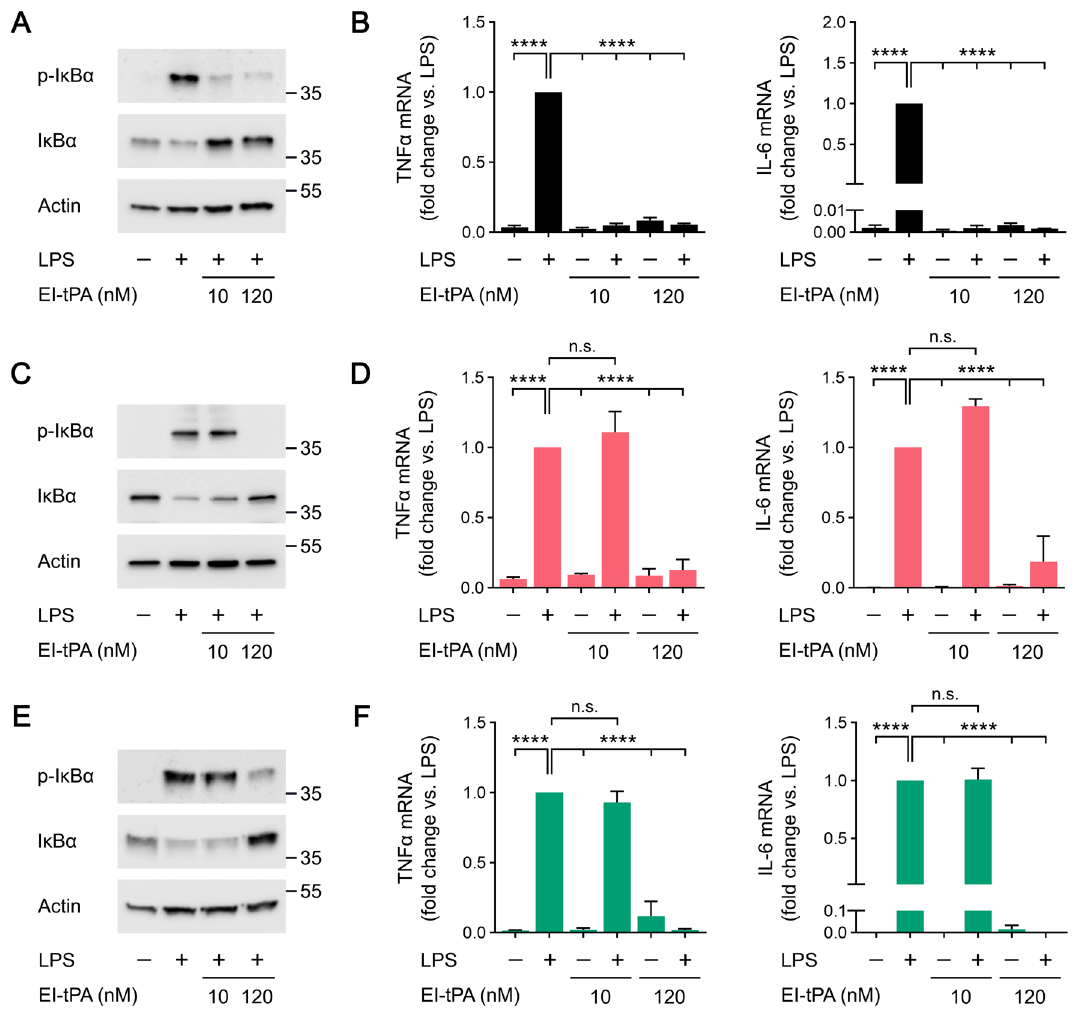
Figure 4. The anti-inflammatory activity of EI-tPA is facilitated by membrane-anchored PrP C and LRP1. ( A ) BMDMs isolated from WT mice were treated for 1 h with LPS (0.1 μg/mL), LPS plus 10 nM El-tPA, LPS plus 120 nM El-tPA, or vehicle. Cell extracts were subjected to immunoblot analysis to detect phospho-IκBα, total IκBα, and β-actin. (B) WT BMDMs were treated with LPS (0.1 μg/mL), LPS plus 10 nM El-tPA, LPS plus 120 nM El-tPA, or vehicle for 6 h. RT-qPCR was performed to compare mRNA levels for TNFα and IL-6 (n = 4–6). (C) PrP C -deficient BMDMs isolated from Prnp −/− mice were treated for 1 h with LPS (0.1 μg/mL), LPS plus 10 nM El-tPA, LPS plus 120 nM El-tPA, or vehicle. Cell extracts were subjected to immunoblot analysis to detect phospho-IκBα, total IκBα, and β-actin. (D) PrP C -deficient BMDMs were treated with LPS (0.1 μg/ mL), LPS plus 10 nM El-tPA, LPS plus 120 nM El-tPA, or vehicle for 6 h. RT-qPCR was performed to compare mRNA levels for TNFα and IL-6 (n = 4–5). (E) LRP1-deficient BMDMs isolated from mLrp1 −/− mice were treated for 1 h with LPS (0.1 μg/mL), LPS plus 10 nM El-tPA, LPS plus 120 nM El-tPA, or vehicle. Cell extracts were subjected to immunoblot analysis to detect phospho-IκBα, total IκBα, and β-actin. (F) LRP1-deficient BMDMs were treated with LPS (0.1 μg/mL), LPS plus 10 nM El-tPA, LPS plus 120 nM El-tPA, or vehicle for 6 h. RT-qPCR was performed to compare mRNA levels for TNFα and IL-6 (n = 4–5). Data are expressed as the mean ± SEM (One-way ANOVA; **** P < 0.0001, n.s.: not statistically LRP1 is required for and PrP C facilitates the BMDM response to activated α M . Treatment of WT 2 BMDMs with activated α 2 M, at concentrations from 2.0 to 120 nM, in the absence of LPS, activated ERK1/2 (Fig. 5A). In PrP C -deficient BMDMs harvested from Prnp −/− mice, the concentration of α 2 M required to activate ERK1/2 was increased to 60 nM (Fig. 5B). In LRP1-defiicent BMDMs, ERK1/2 activation was not observed throughout the α 2 M concentration range studied (Fig. 5C). Next, we studied the activity of α 2 M as an antagonist of LPS responses in BMDMs. In WT BMDMs, 10 nM α 2 M and 120 nM α 2 M blocked the increase in IκBα phosphorylation and the accompanying decrease in IκBα abundance induced by LPS (Fig. 6A). α 2 M, at 10 or 120 nM, also completely blocked LPS-induced expression of TNFα and IL-6 (Fig. 6B). In PrP C -deficient macrophages, 10 nM α 2 M failed to block LPS-induced IκBα phosphorylation (Fig. 6C) and the increase in expression of TNFα and IL-6 caused by LPS (Fig. 6D). The activity of α 2 M was restored when